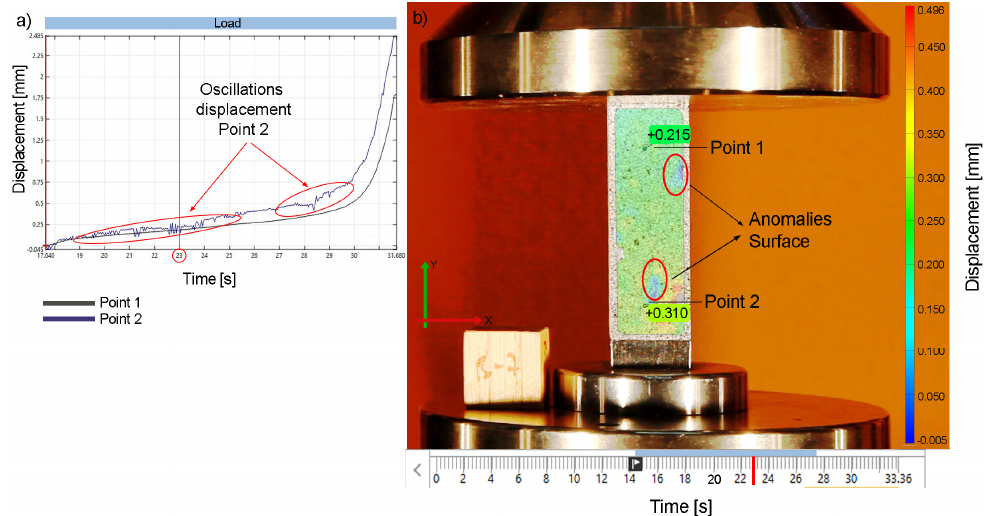
Figure 12. ( a )DisplacementdiagramwithoscillationsofPoint2(P 2 )and( b )anomaliesofthedisplacements on the surface of specimen